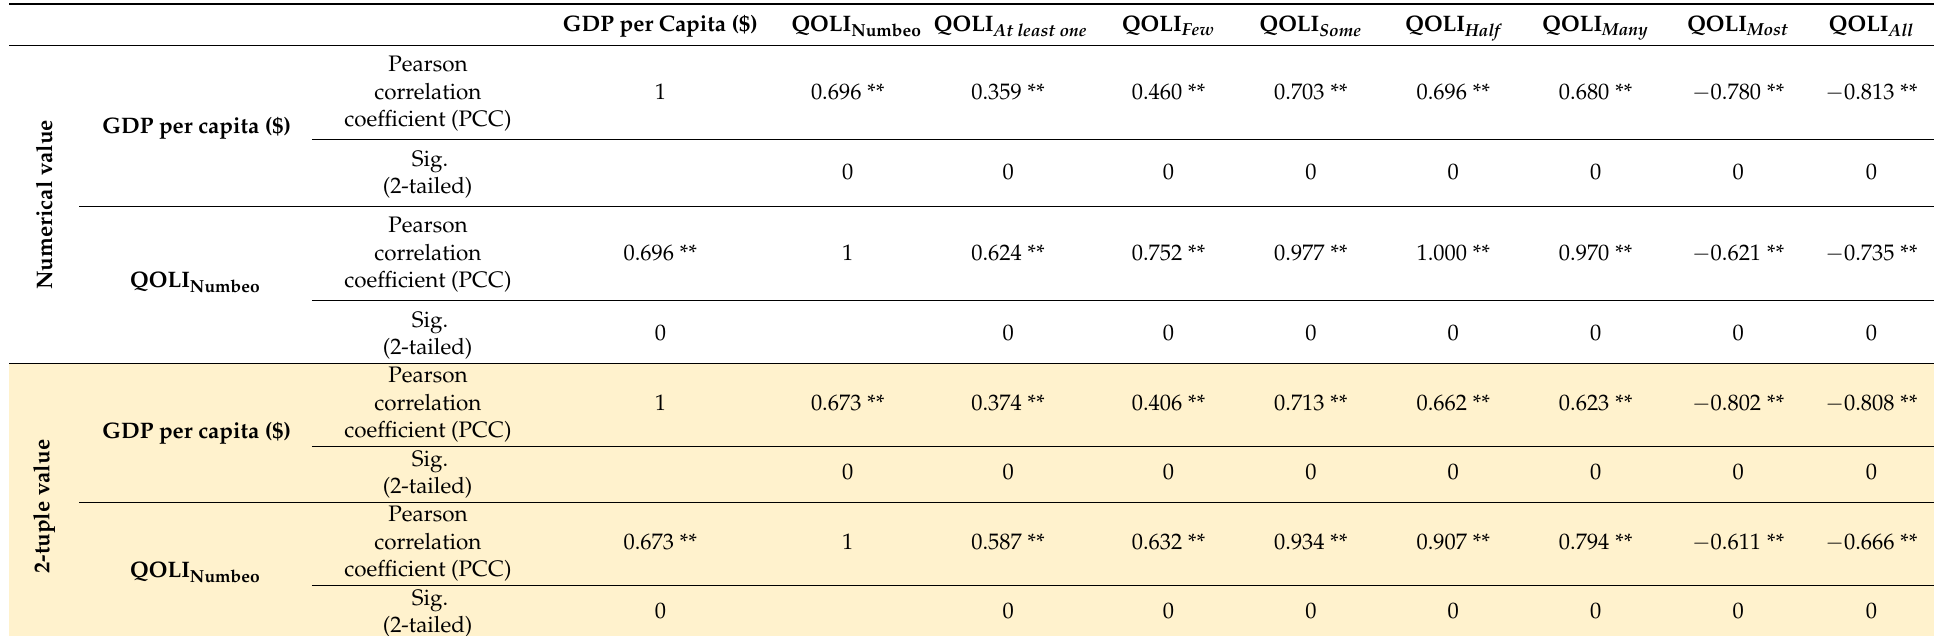
Table 14. Correlation analysis between the QOLI values and GDP per capita (number versus. 2-tuple value). GDP per Capita ($)